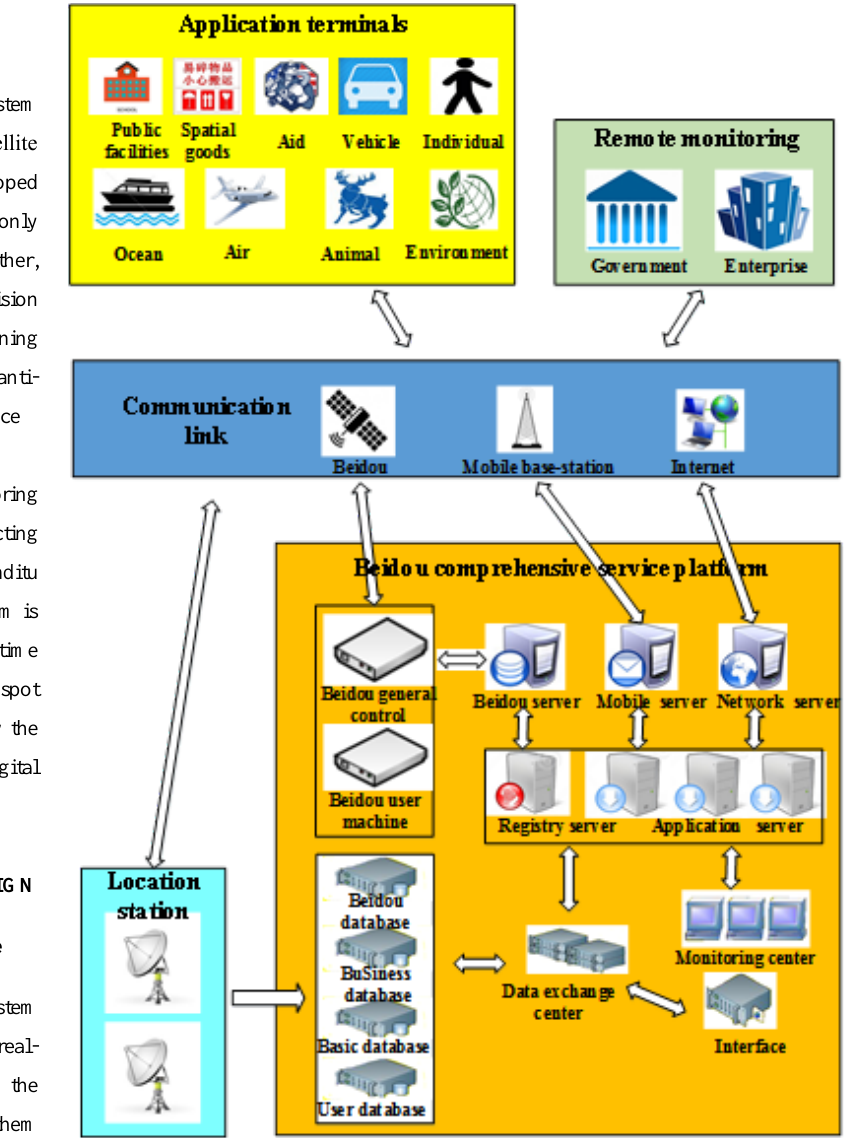
Figure 2: BeiDou Navigation Satellite System frame diagram